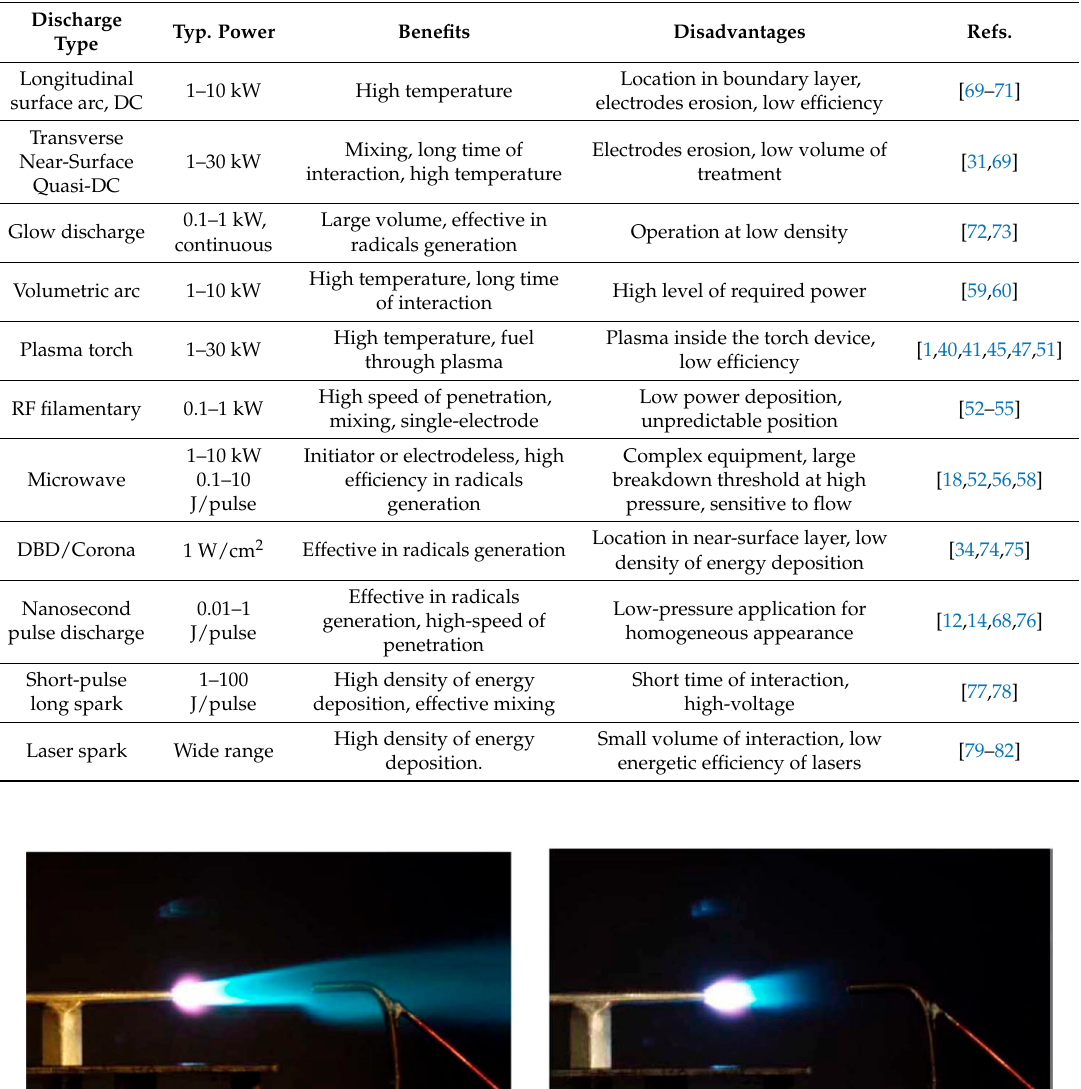
Table 1. Brief characterization of electric discharges used for PAC and flow control [67].